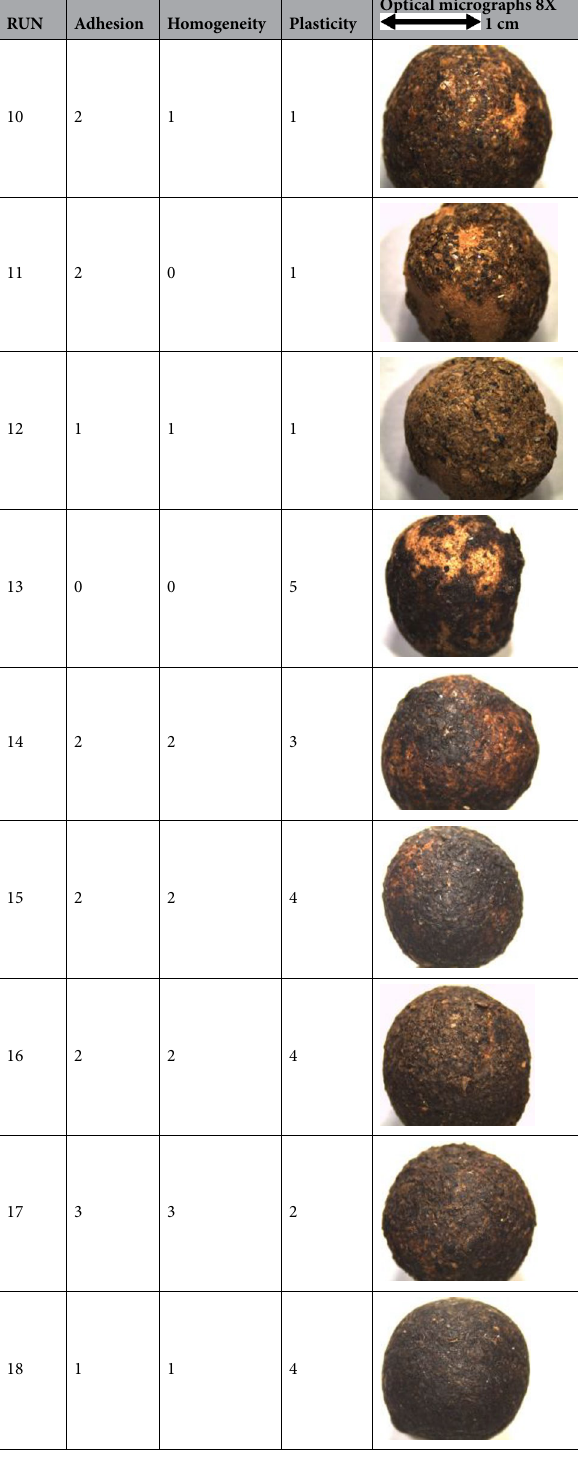
Table 5. Complete experimental